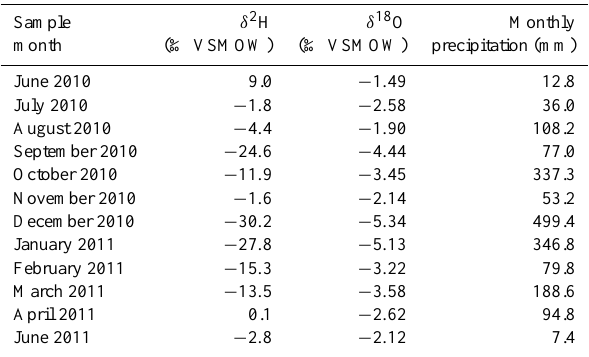
Table 5. Rainfall stable isotopes collected from the Brisbane Air- port between June 2010 and June